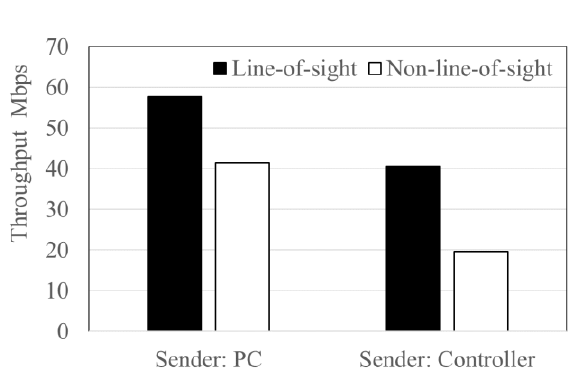
Figure 16. Experimental environment of excavator: The position of the excavator’s bucket is different. Left side is line-of-sight communication between the PC and the controller, and right side is non-line-of-sight communication (the distance between the PC and the controller is 10 m).